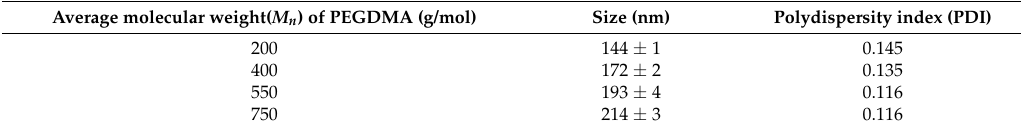
Figure 2. ( a ) Representative TEM images of: ( a ) p [NIPAm- co -PEGMA] core nanogels; ( b ) p [NIPAm- co -PEGMA] (core) /p [NIPAm- co -AAc (shell)] nanogels with uranyl acetate staining. ( c ) Variation in hydrodynamic sizes of the nanogels (squares) and variation in mole ratio of the crosslinker (triangles), as a function of the average molecular weight of the crosslinker ( M n ) at 25 ° C. The error bar represents the standard deviation from triplicate measurements. ( d ) Variation in polydispersity indices (PDIs) as a function of the average molecular weight of the crosslinker at 25 ° C. Error bars represent the standard deviation of triplicate measurements. Table 2. Comparison of hydrodynamic sizes and PDIs of nanogels synthesized using varying PEGDMA at 25 ° C.